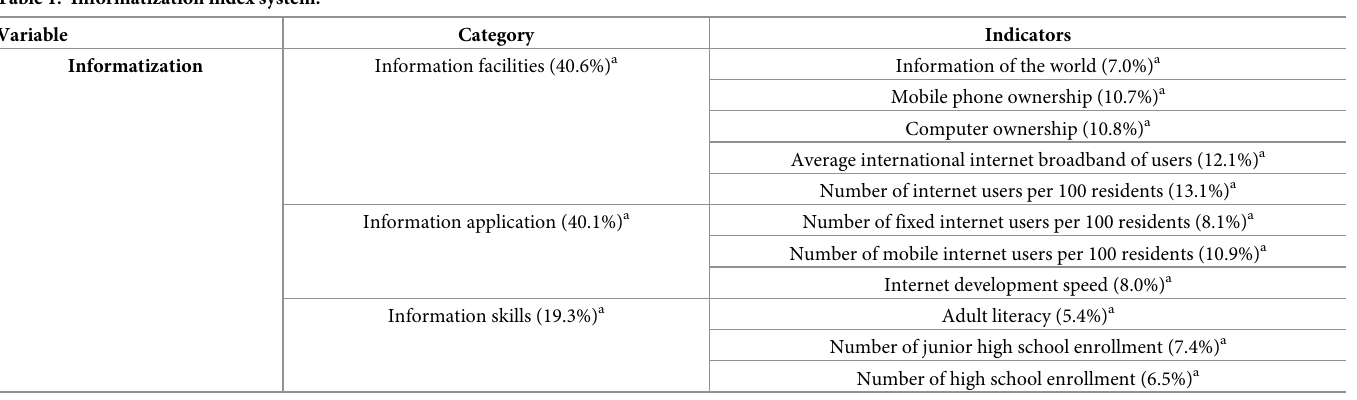
Table 1. Informatization index